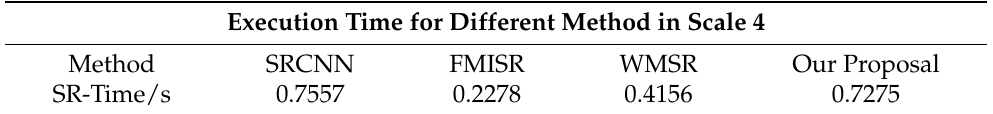
Table 3. Computational time of different methods.